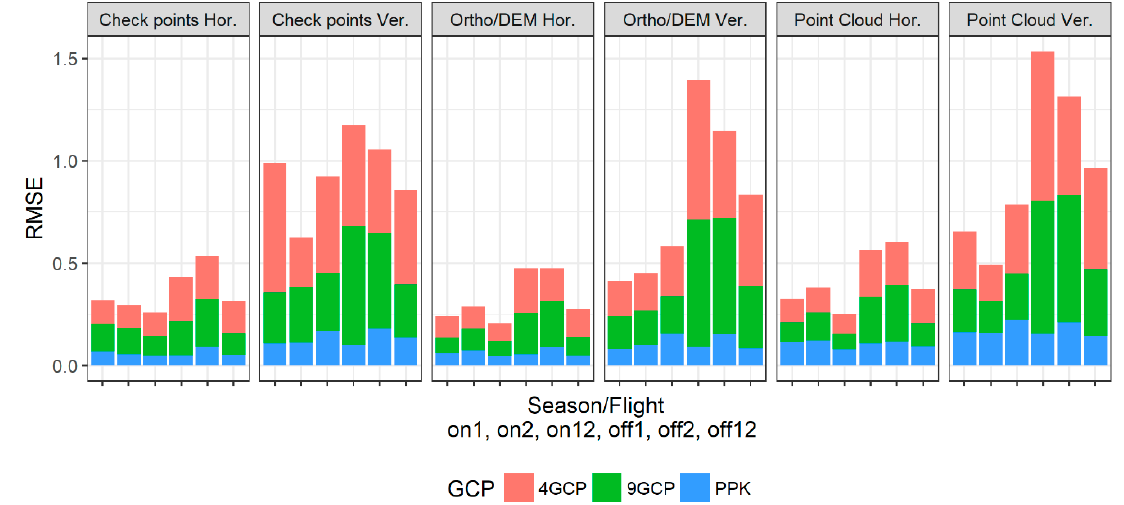
Figure 9. Histograms of horizontal and vertical RMSE split by approach of check points placing and divided by georeferencing method (colour) and season and flight pattern (x axis).